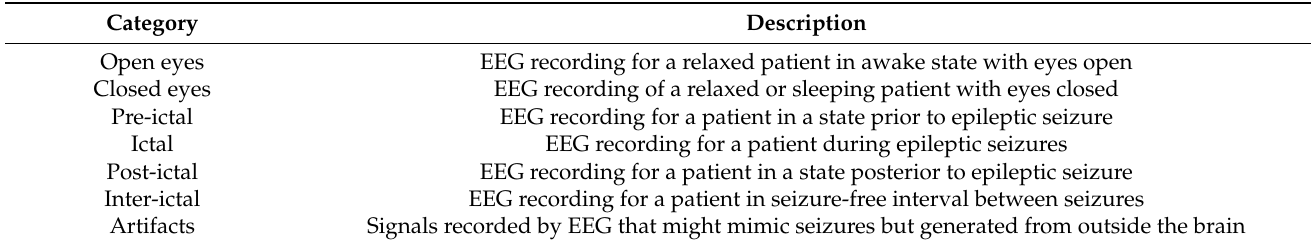
Table 3. Description Of EEG Categories For Annotated Local Dataset.